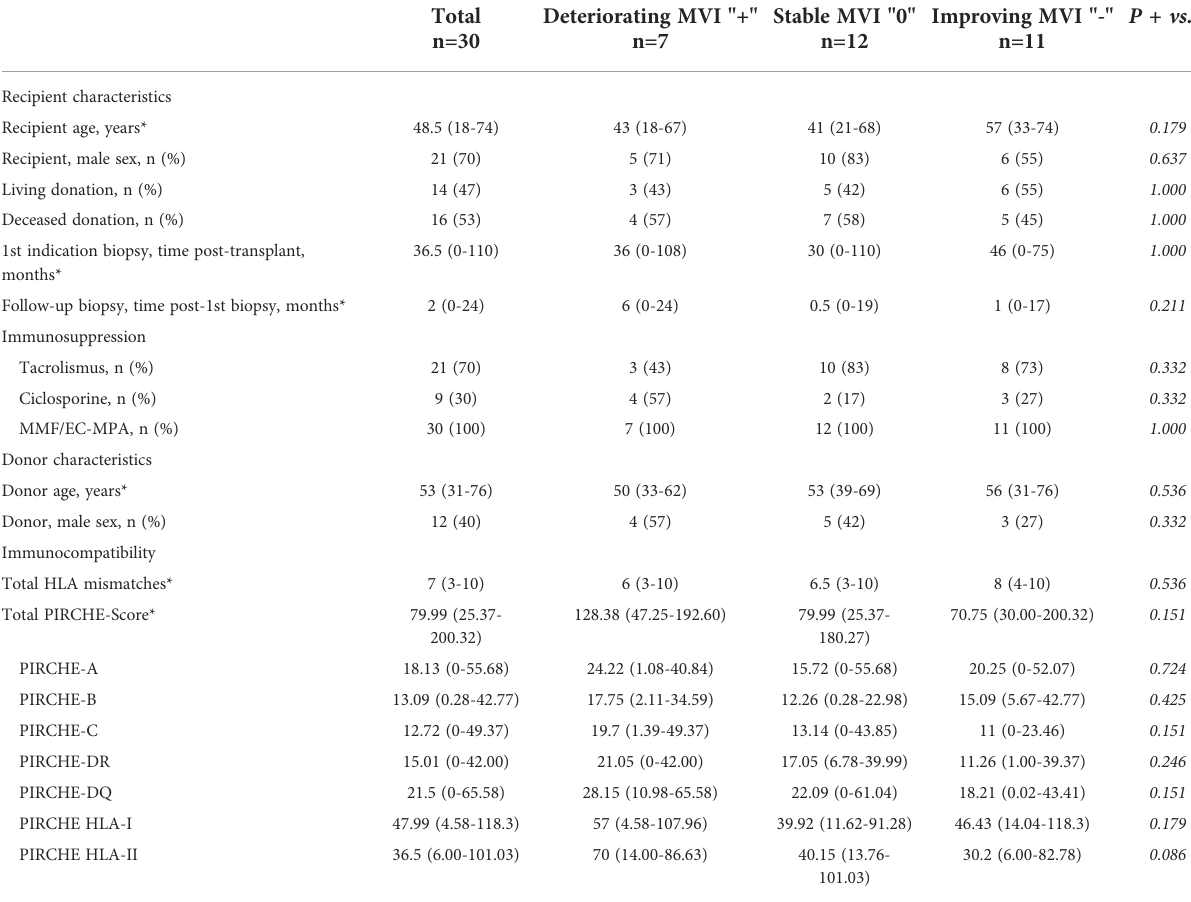
TABLE 3 Basic characteristics of 30 KTRs with ABMR in the fi rst indication biopsy and grouping based on the results of the follow-up